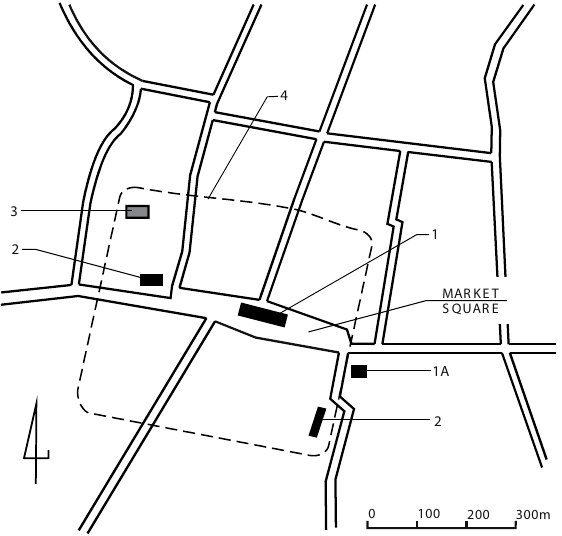
Fig. 1 . Plan of Środa Śląska, town descending from commerci- al settlement: 1 – former town hall present historic museum, 1A – new town hall; 2 – church; 3 – ruin of castle; 4 – battle-